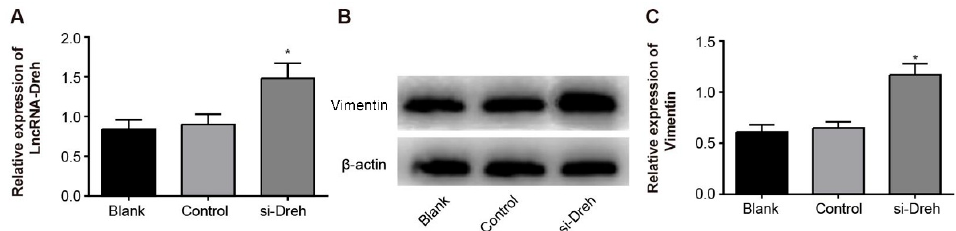
Figure 6. The Vimentin expression of WB-F344 cells increases after silencing of LncRNA-Dreh. ( A ) mRNA expression of Vimentin increased in WB-F344 cells after inhibition of LncRNA-Dreh measured by RT-qPCR; ( B ) the density of Vimentin and β -actin in WB-F344 cells of the blank, control and si-Dreh groups; ( C ) relative expression of Vimentin increased in WB-F344 cells after inhibition of LncRNA-Dreh measured by Western blot analysis; * p < 0.05, vs. the blank and control groups. Cells without any transfection were used as the blank group, cells with blank plasmid transfection were used as the control group. The results are given as means ± SD ( n = 3 samples). Enumeration data were performed according to ANOVA with chi-square test ( p < 0.05).